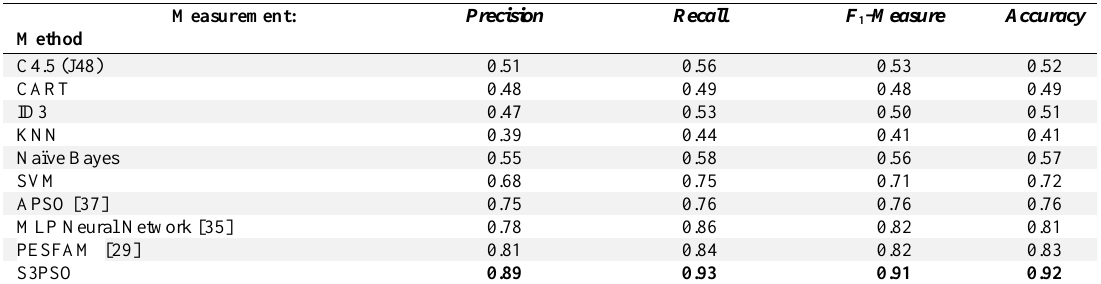
Table 6. Results of Precision , Recall , F 1 -measure , and Accuracy measurements for different methods on the used Moodle case study.